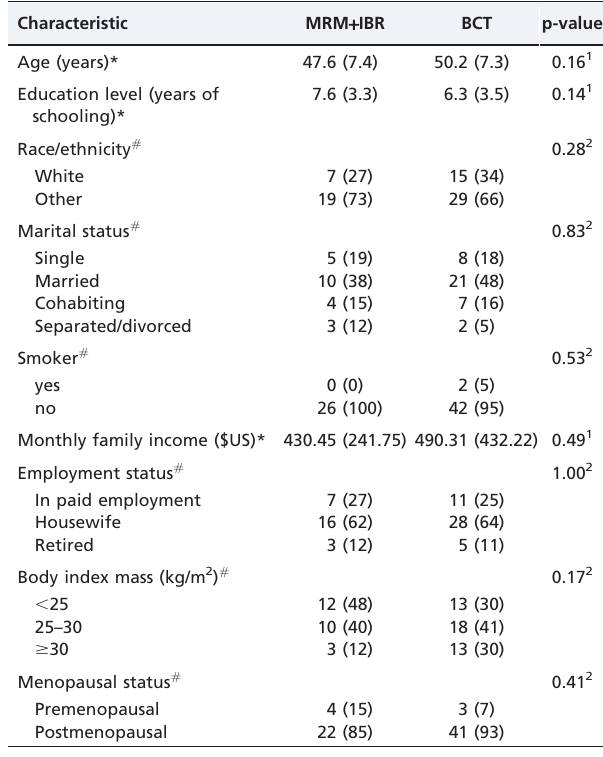
Table 2 - Sociodemographic and clinical features of women with breast cancer submitted to MRM + IBR(n = 26) or BCT (n=